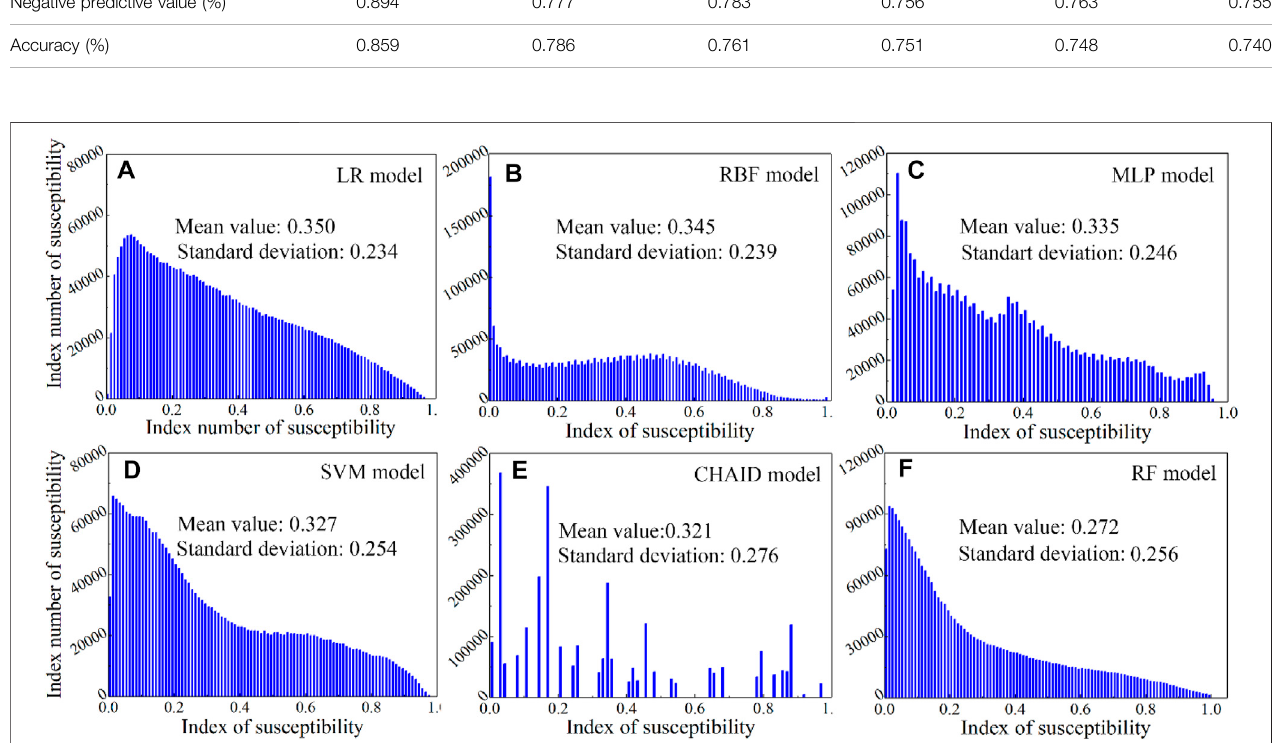
FIGURE 9 | Collapse susceptibility indexes distributions of different models: (A) LR model, (B) RBF, (C) MLP, (D) SVM, (E) CHAID, and (F) RF models.